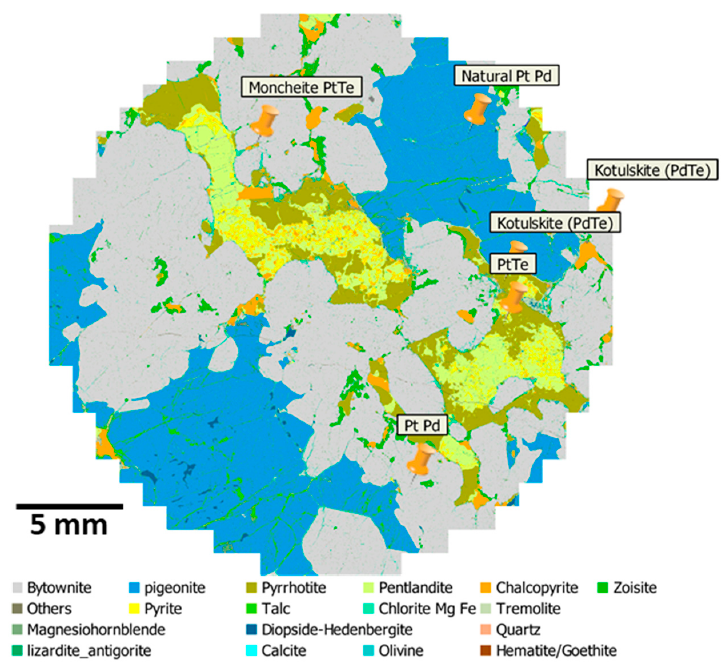
Figure 3. Mineral map obtained by TIMA for the PGE1a sample.